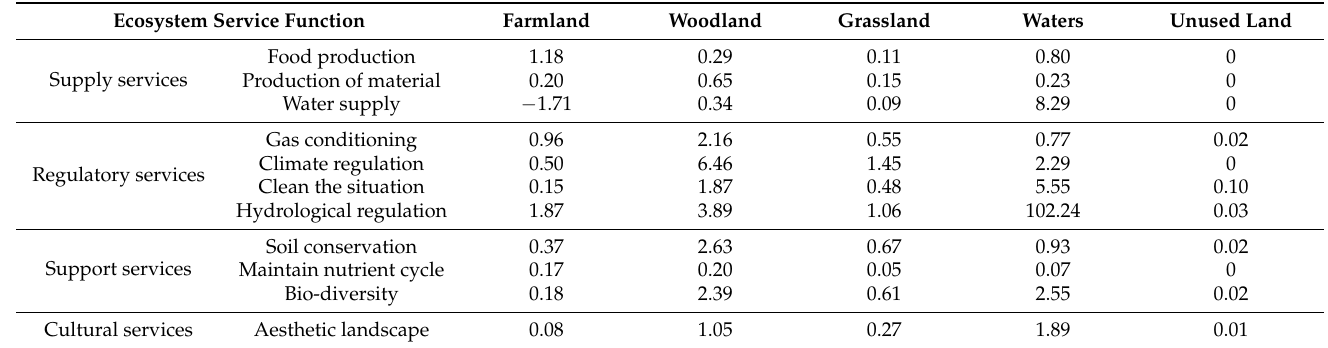
Table A1. South Jiangsu Ecosystem Service Value Coefficient [Unit: 10,000 yuan/(hm 2 · year)].